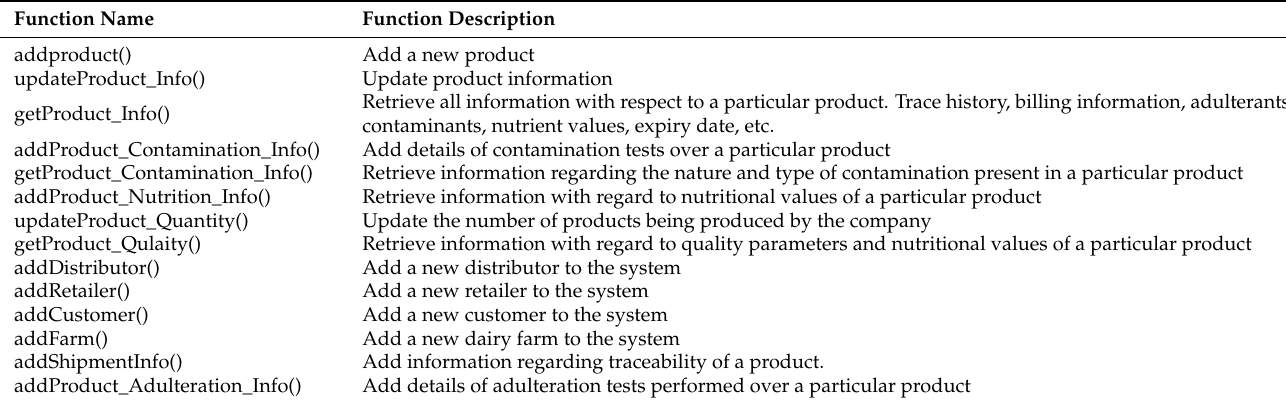
Table 5. Smart Contract Functions